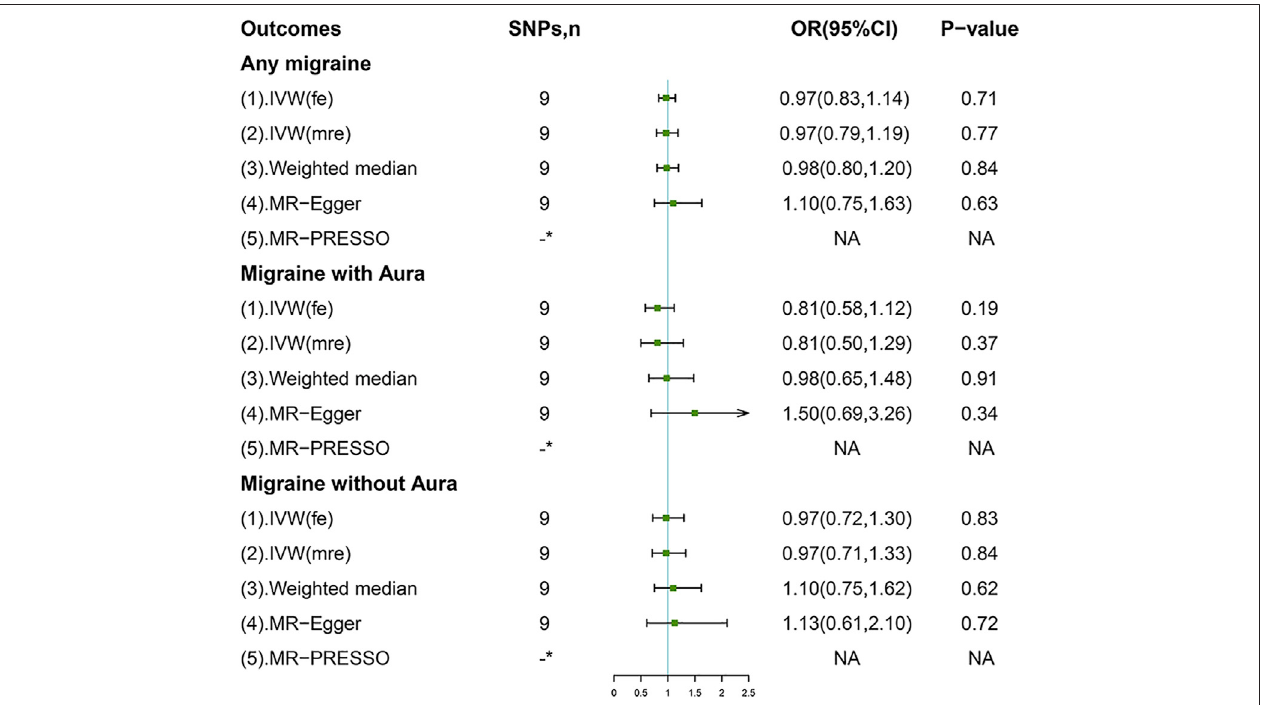
FIGURE 2 | Associations of genetically predicted coffee consumption with migraine and its subtypes. IVW (fe), fi xed-effects inverse-variance weighted; IVW (mre), multiplicative random-effects inverse-variance weighted; MR-Egger, Mendelian randomization-Egger; MR-PRESSO, Mendelian randomization pleiotropy residual sum and outlier method; NA, not available. *No outliers